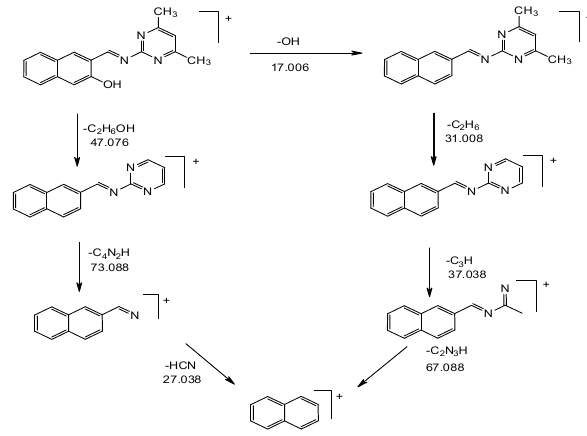
Scheme 2 : Fragmentation pattern of 3-{( E )-[(4,6-dimethylpyrimidin- 2-yl)imino]methyl}naph thalen-2-ol